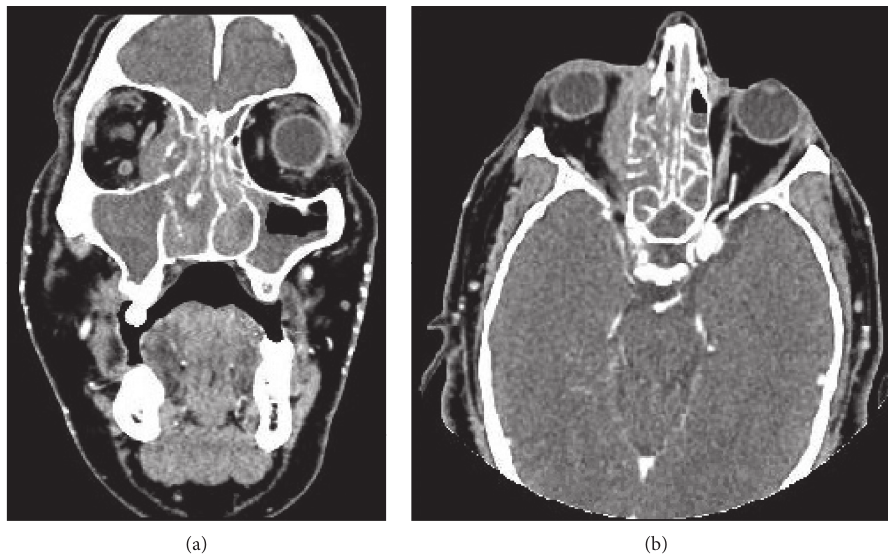
Figure 1: CT maxillofacial with IV contrast showing opacified ethmoid sinuses with bone destruction of the right lamina papyracea with soft-tissue extension into the right orbit. (a) Coronal view; (b) axial